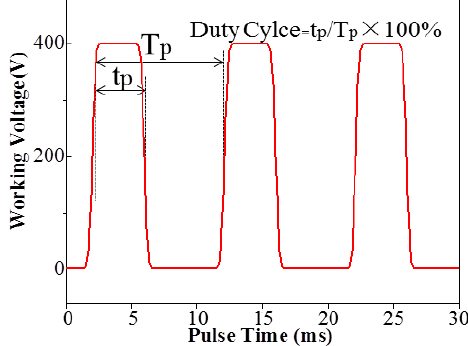
Figure 3. The output oscillogram of impulse voltage.